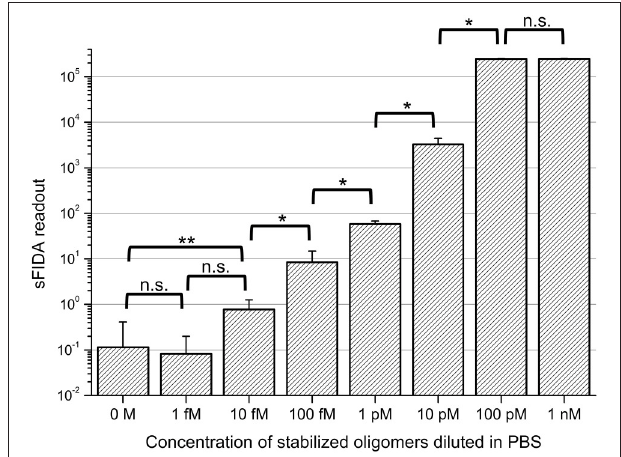
FIGURE 2 | sFIDA readout of stabilized oligomers diluted in PBS. Columns and error bars represent the mean values and standard deviations calculated from a fourfold determination of samples containing oligomers. The blank was determined 21-fold. Cutoffs for each channel were set to discard virtually all background from control samples except for 25 pixels, which are 0.01% of all pixels. This led to the following cutoff values (channel 635nm/channel 488nm): 4082/2773. Please note that the number of colocalized pixels (sFIDA readout) is lower than the number of pixels above background in the single channels. n.s., not significant; * p ≤ 0.05 ; ** p ≤ 0.01 .